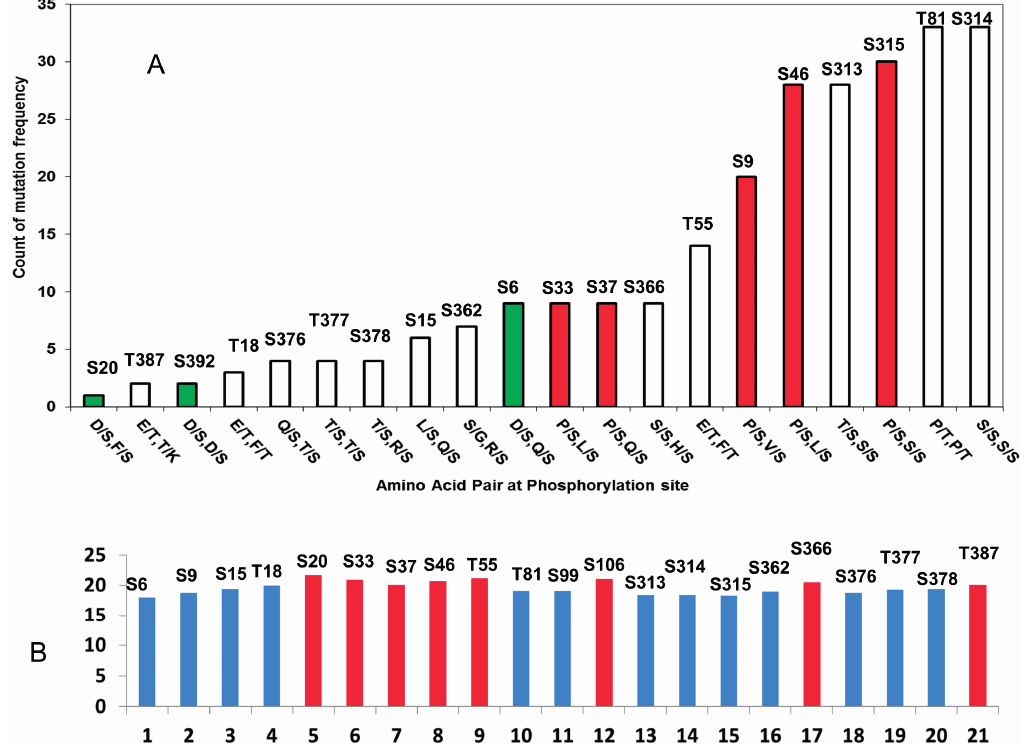
Figure 4. p53 phosphorylation motifs can be characterized by amino acids adjacent to the phosphorylation motif and the propensity of structural disorder of the seven residue phosphorylation motif. ( A ) Phosphorylation motifs with D/S pattern (green bar) have fewer mutations than the motif with the P/S pair (red bar); ( B ) Phosphorylation motifs are structurally disordered (blue bar), some motifs, which are less disordered (red bar), have more secondary structure